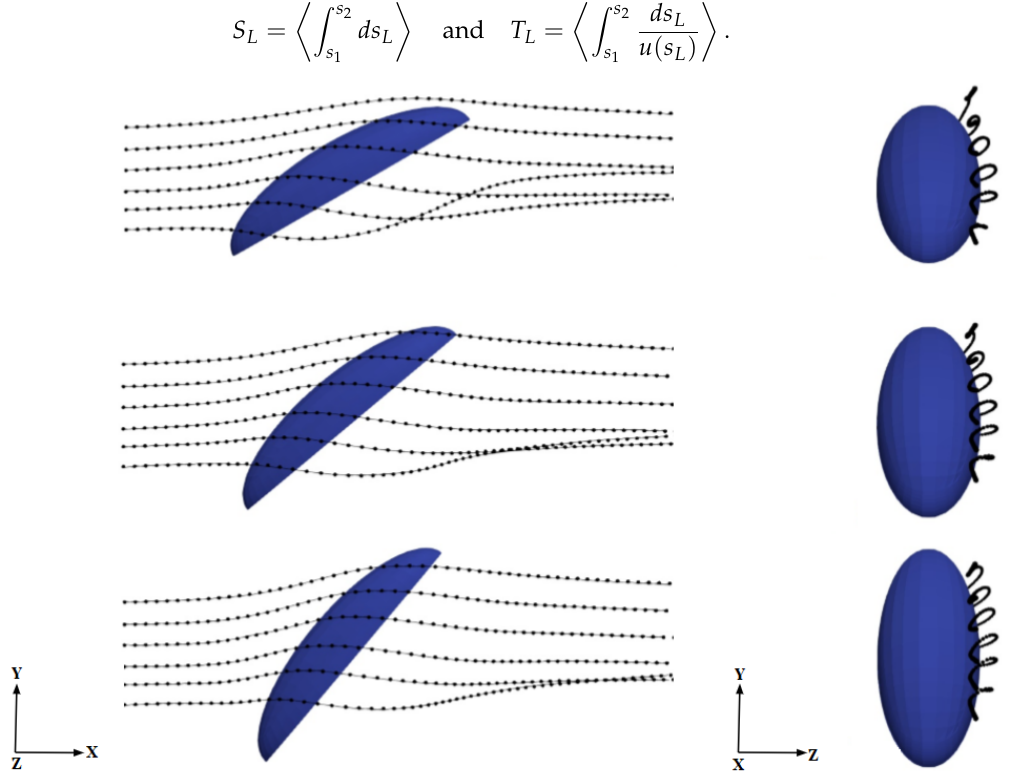
Figure 7. Lateral (left) and longitudinal (right) views of sample droplet trajectories. From top to bottom: α = 30 deg (run A4), 40 deg (run A6) and 60 deg (run A10). At their leftmost injection locations, droplets are placed on a vertical (x–y) plane at a distance of 0.87 mm from the body’s symmetry plane and the vertical separation between adjacent droplets at their injection locations is 0.2